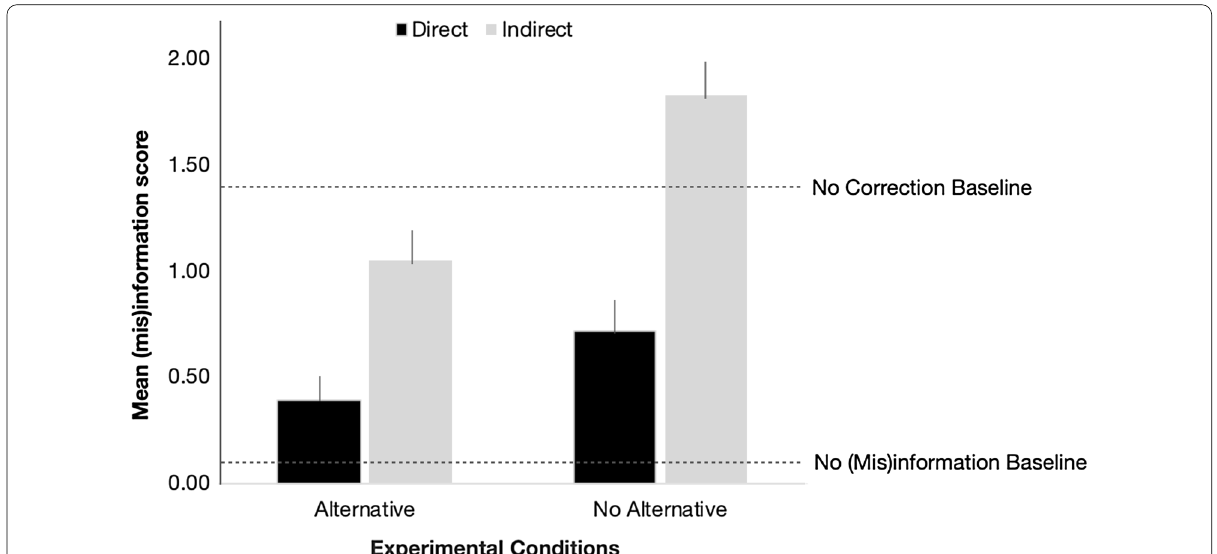
Fig. 4 Mean (mis)information score in Experiment 1B. Means for baseline participants are indexed with dotted lines. Error bars indicate standard error of the